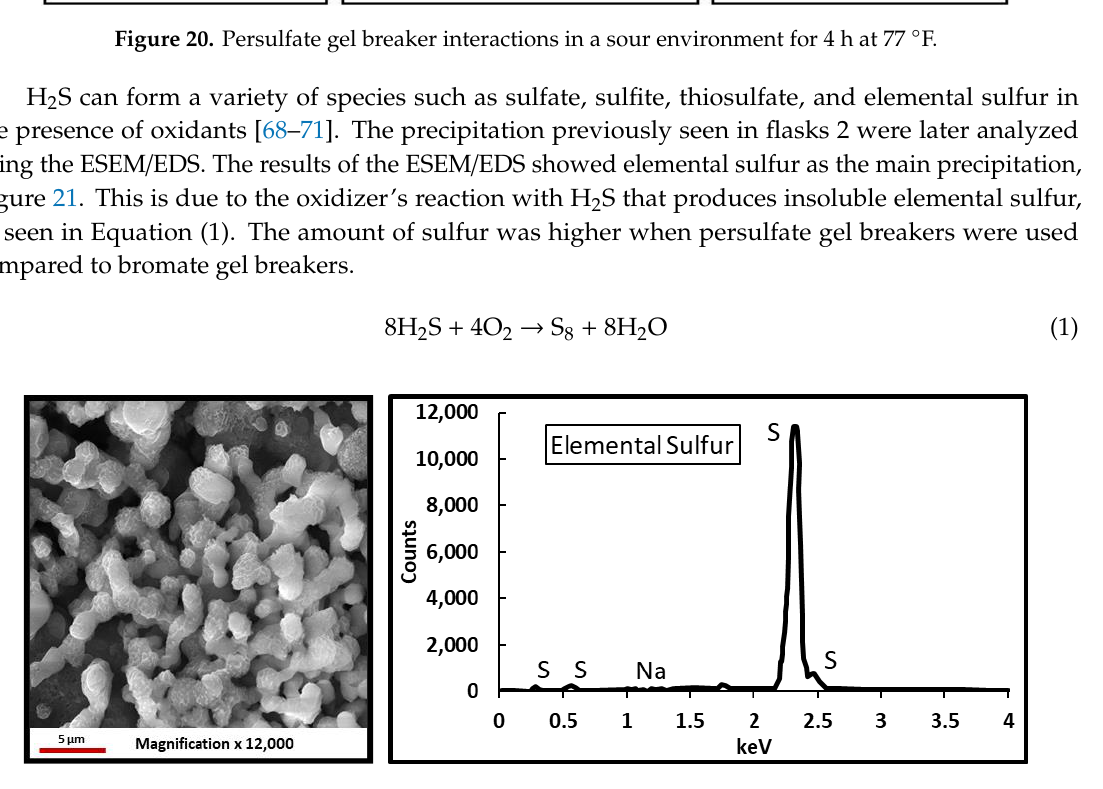
Figure 21. Environmental scanning electron microscope (ESEM) analysis of the precipitation from oxidizer gel breaker interactions in a sour environment for 4 h at 77 °F.